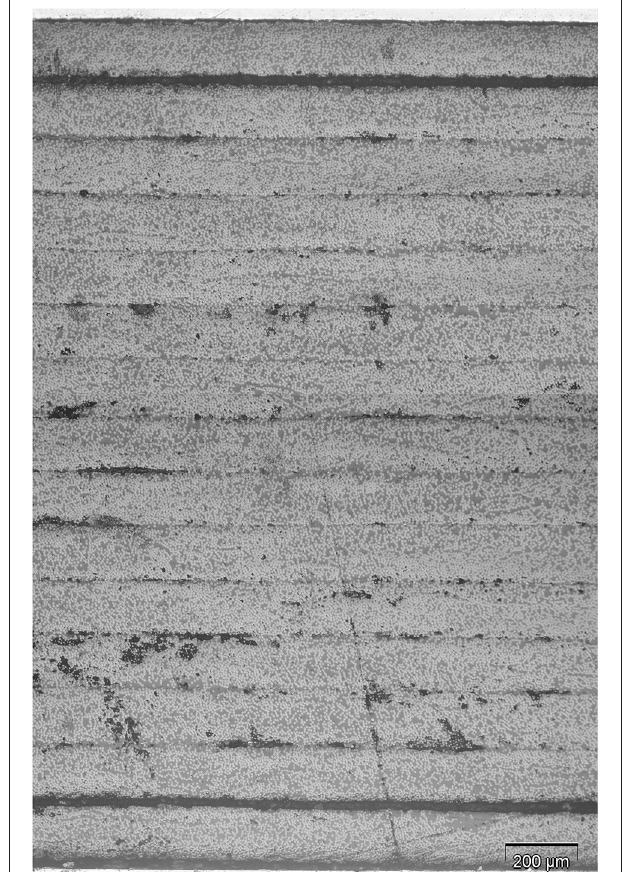
FIGURE 9 | Micrographic image of laminate consolidated by one side heating plate. FIGURE 10 | Micrographic image of the laminate consolidated at 230 ◦